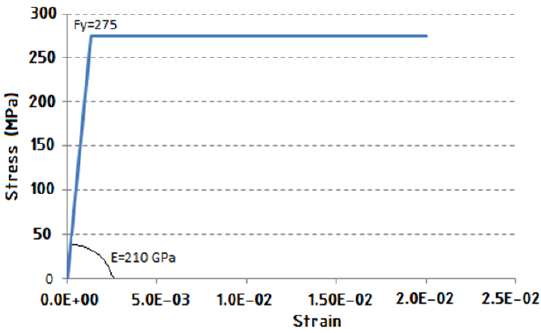
Figure 9 : Stress deformation scheme for steel (current study)